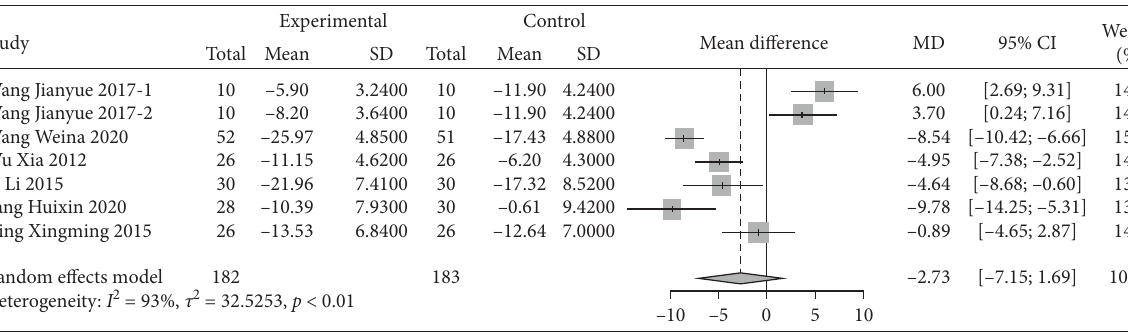
Figure 6: Meta-analysis of the comparison of ODI scores between the traditional Chinese exercise group and the control